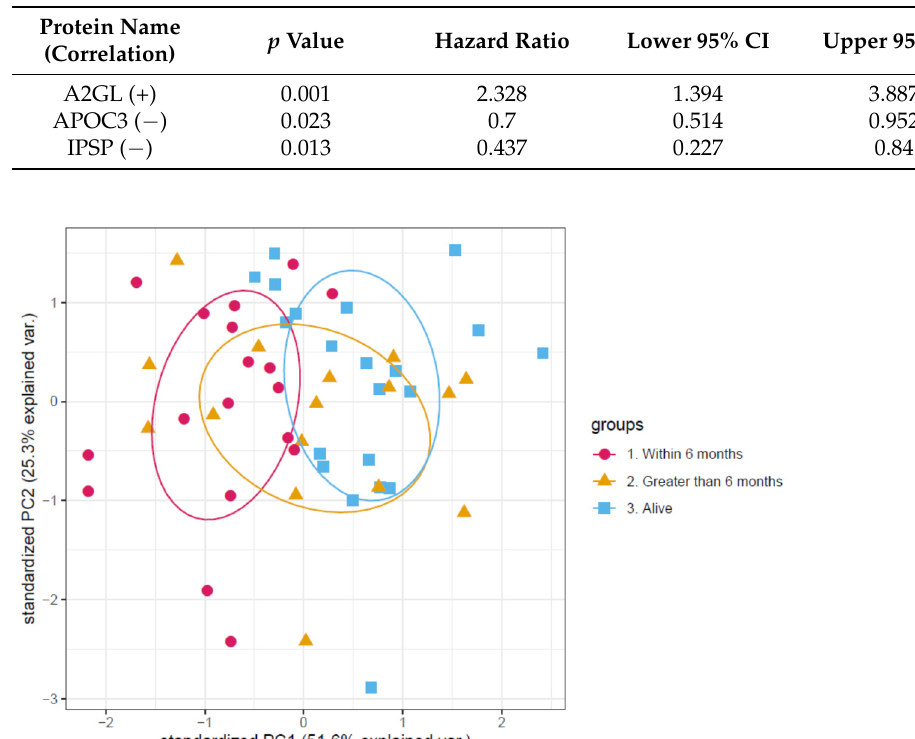
Figure 1. Principal component analysis of the protein abundance levels of the final panel of proteins. Each point in the principal component analysis is an individual patient sample. Patients are colour coded according to the patient’s survival time after samples were taken. With those still alive at time of analysis coloured in blue, those who survived longer than 6 months coloured in orange and those who died within 6 months coloured in magenta. There is a separation between those that died within 6 months and the remainder of the samples along the first principal component with an explained variation of 51.6%.